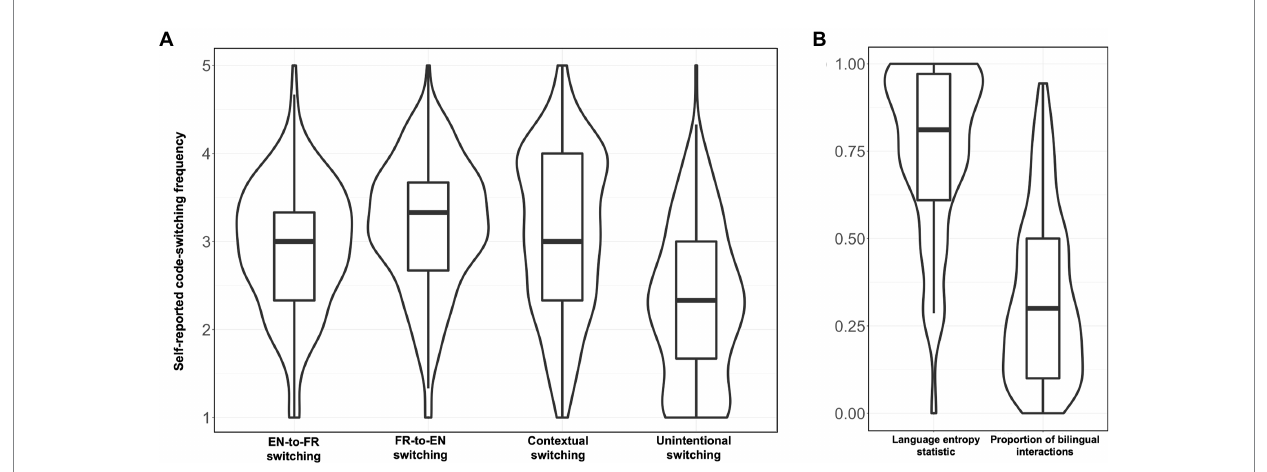
FIGURE 1 (A) Individual variation in code-switching habits (BSwQ components; Rodriguez-Fornells et al., 2012) for all participants. (B) Individual variation in the language entropy statistic and proportion of bilingual interactions for all participants. An entropy value of 0 signifies complete linguistic compartmentalization; 1 indicates complete linguistic integration (Gullifer and Titone, 2020). For each variable, the thick black line represents the median, the outline of the box represents the inter-quartile range, the whiskers of the boxplot represent the maximum and minimum values, and the violin outline illustrates the density of the